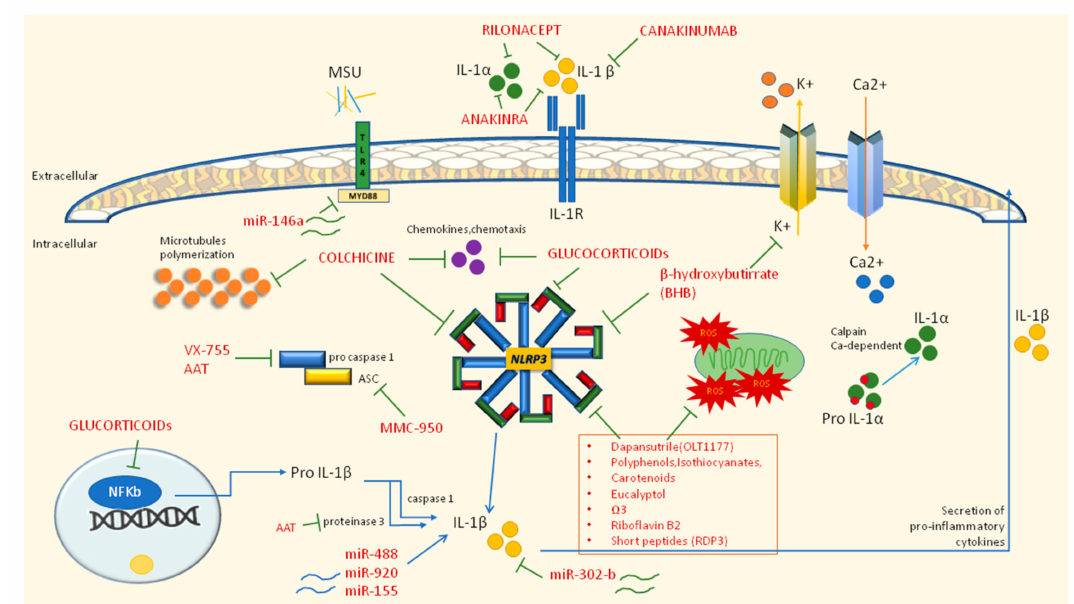
Figure 4. Inhibitory drugs (in red ) of autoinflammatory mechanisms in gouty inflammation. Blue arrows indicate mechanisms of activation (i.e., maturation of IL-1 α and IL-1 β from precursors or the ability of miR-488 and miR-920 to induce the production of IL-1 β ). Green connectors identify inhibitory mechanisms towards NLRP3 or IL-1